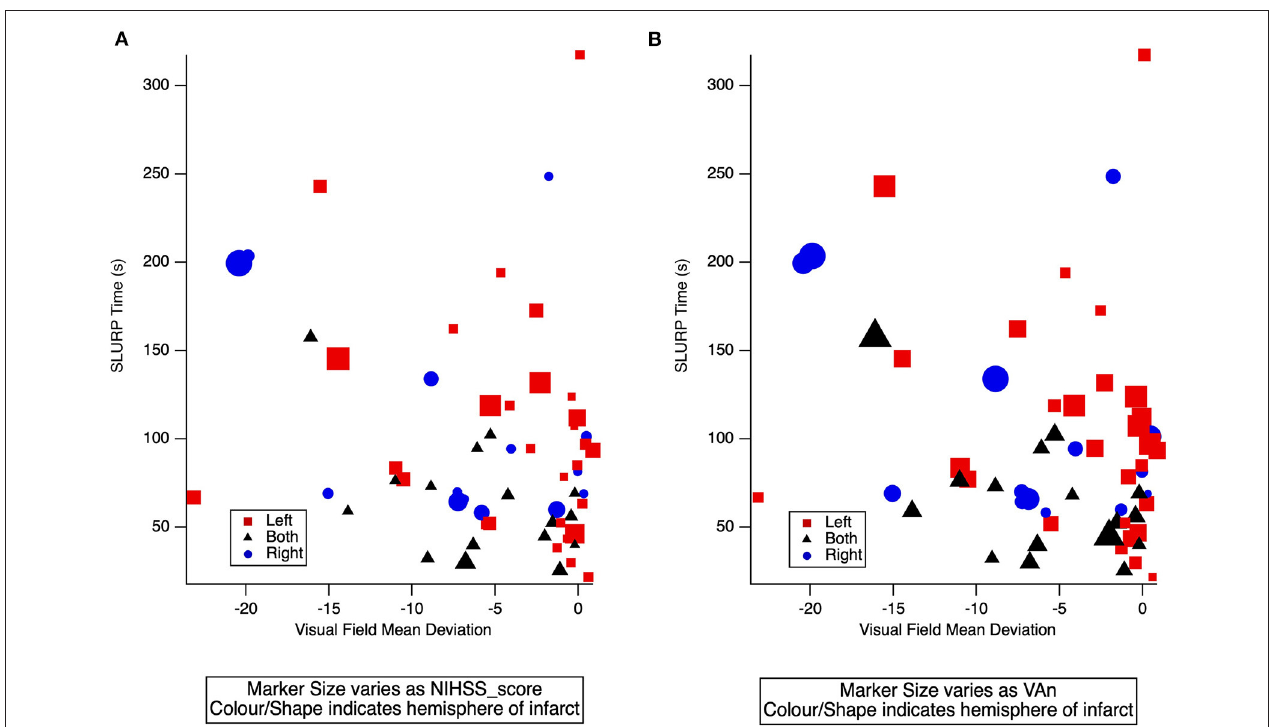
FIGURE 5 | (A) 3-D scatter plot of individual AIS patient EHC (SLURP) time and mean deviation of visual field sensitivity covarying with NIHSS score. (B) 3-D scatter plot of individual AIS patient EHC (SLURP) time and mean deviation of visual field sensitivity covarying with visual acuity-in-noise (VAn). Blue Circle: Right Hemisphere lesion, Red square: Left Hemisphere lesion, Black Triangle: a lesion in both hemispheres. Lesion site and severity of AIS is indicated by shape, color and size of spot